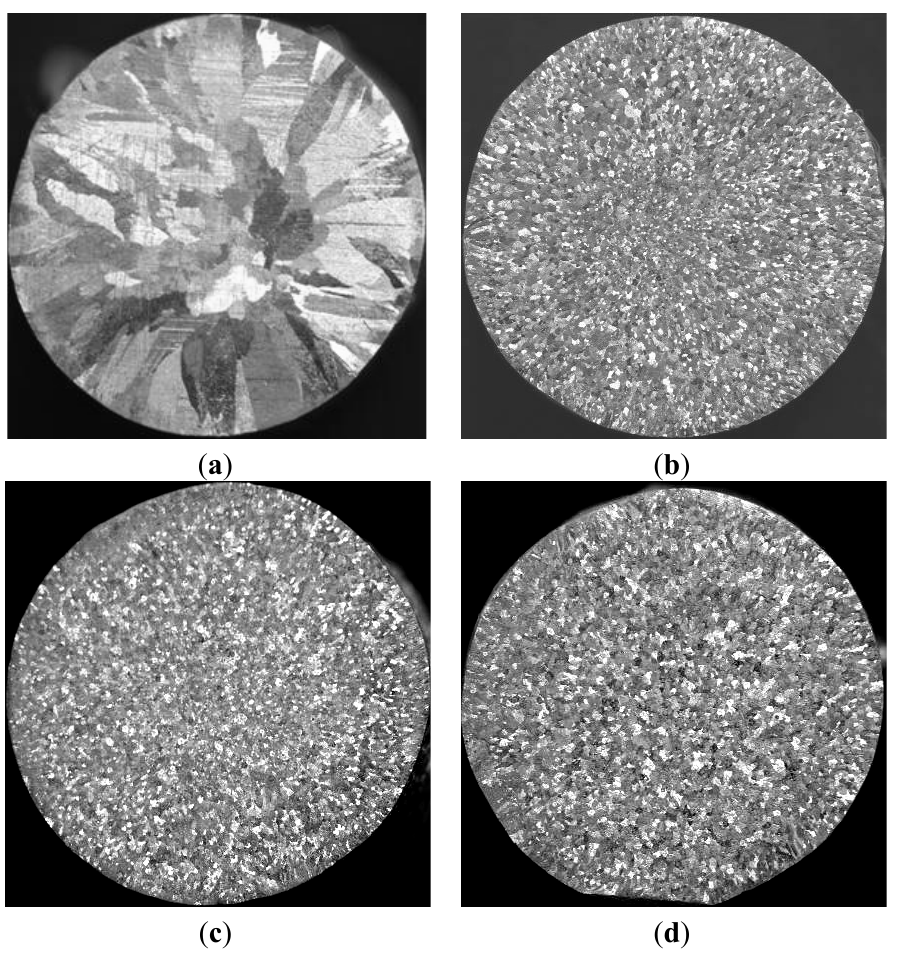
Figure 6. Macrostructures of commercial pure aluminum refined with three types of Al–5Ti master alloys (holding for 5 min): ( a ) Commercial pure aluminum; ( b ) 0.6% master alloy 1 # ; ( c ) 0.6% master alloy 2 # ; and ( d ) 0.6% master alloy 3 # .